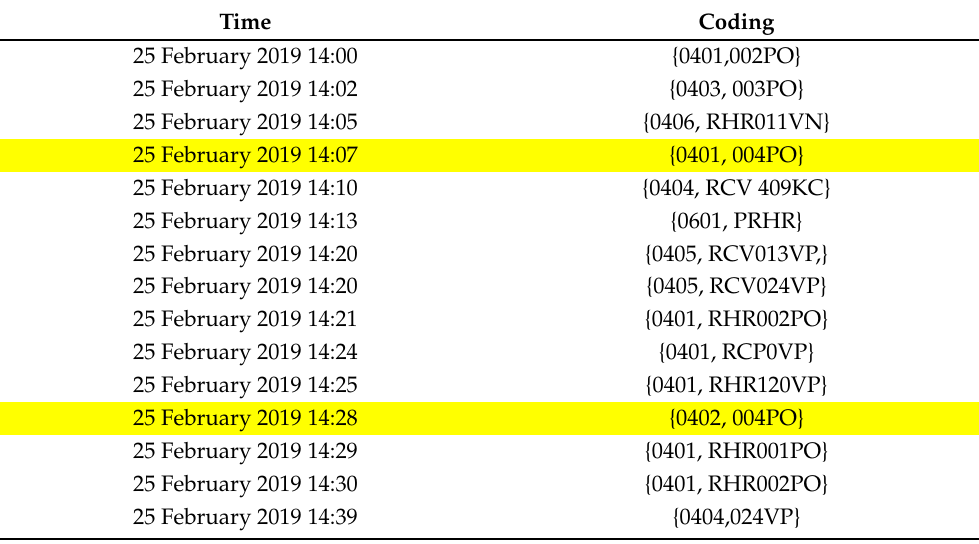
Table 6. Standard actions of the MSM model in Figure